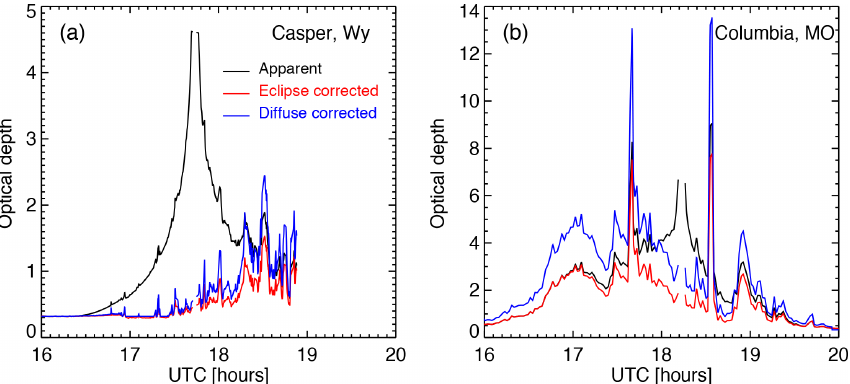
Figure 2. Apparent (black lines), eclipse-corrected (red lines), and diffuse-light-corrected (blue) total optical depths that correspond to spectral radiances at 500nm observed by Pandora systems at (a) Casper and (b) Columbia during the solar eclipse on 21 August 2017.